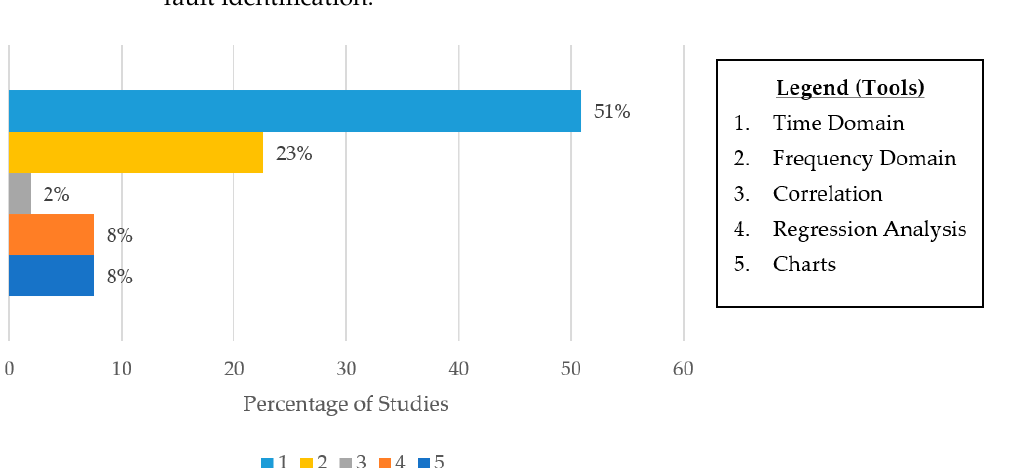
Figure 11. The Pareto chart used to highlight the fault severity in the study by R. Kosturkov et al. [102].